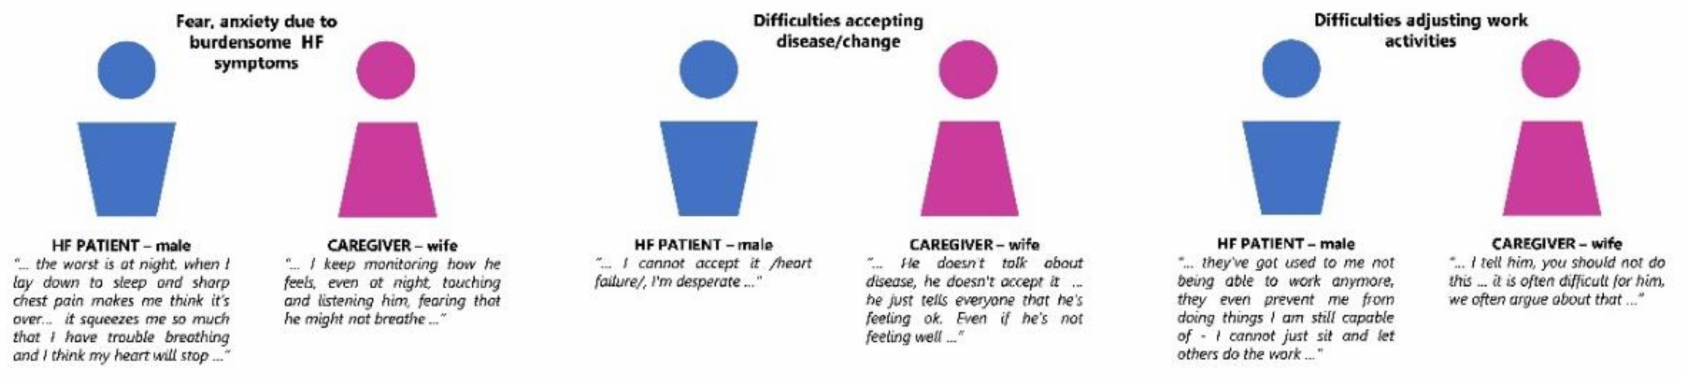
Figure 2. Various e ff ects of heart failure on dyadic interactions and relationships emphasized by interviewed patients and informal caregivers (especially in patient-spouse dyads), that rarely emerged in interviews with healthcare